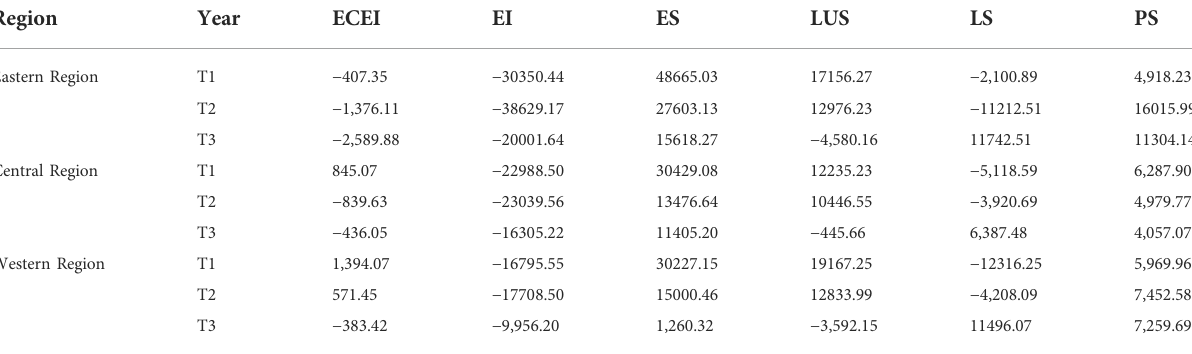
TABLE 7 Decomposition results of in fl uencing factors of carbon emission from land use (unit:10 4 t). Region Eastern Region